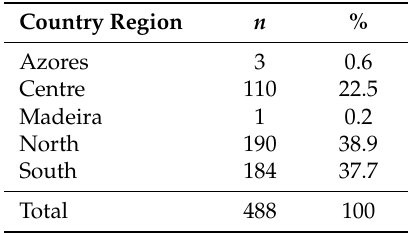
Table 2. Distribution of scientific production by region ( n and %).